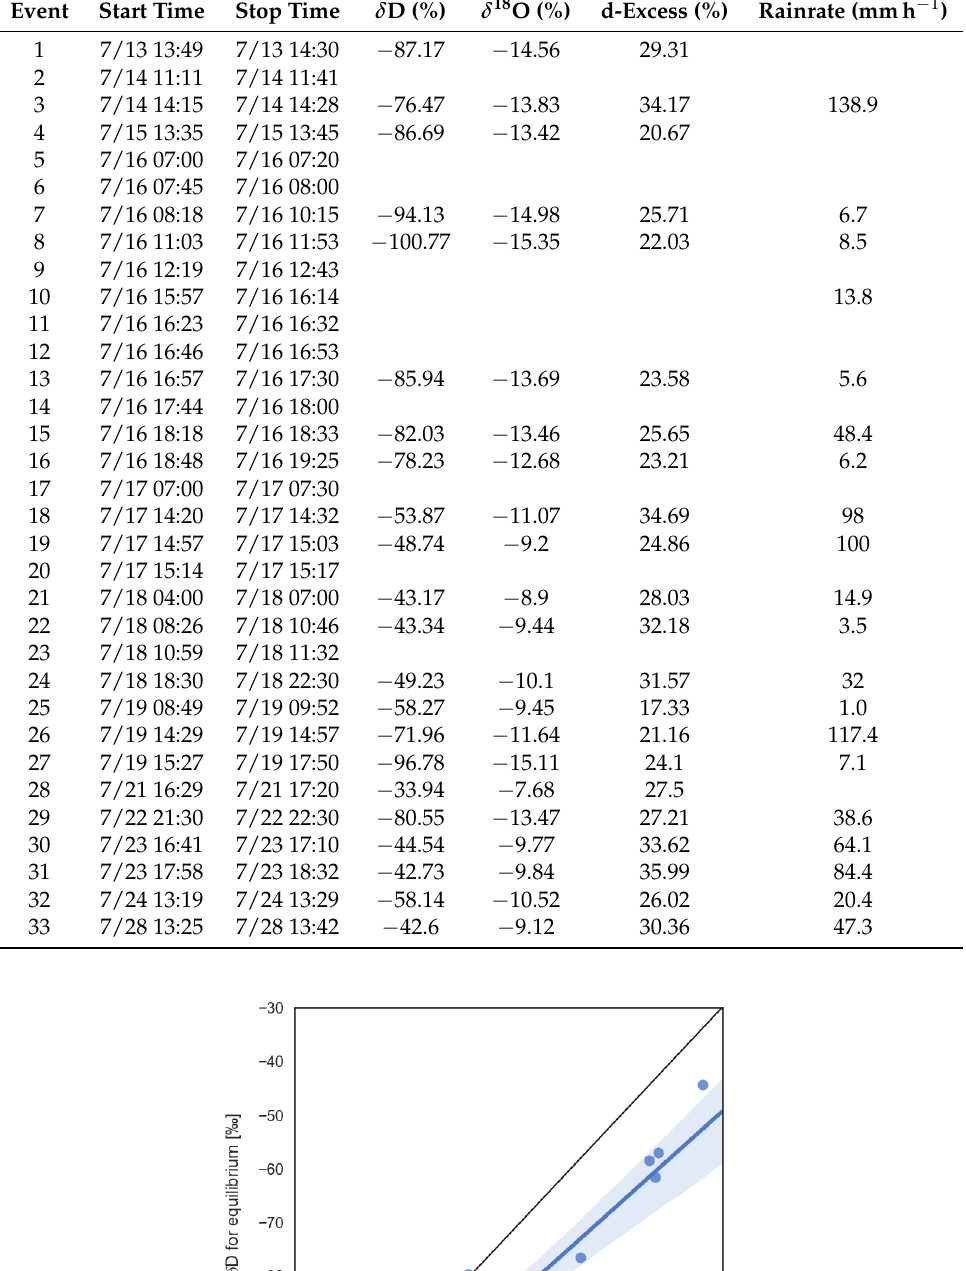
Table 2. Details of rain events during the observation period. Blank cells indicate that the corresponding data were not collected.